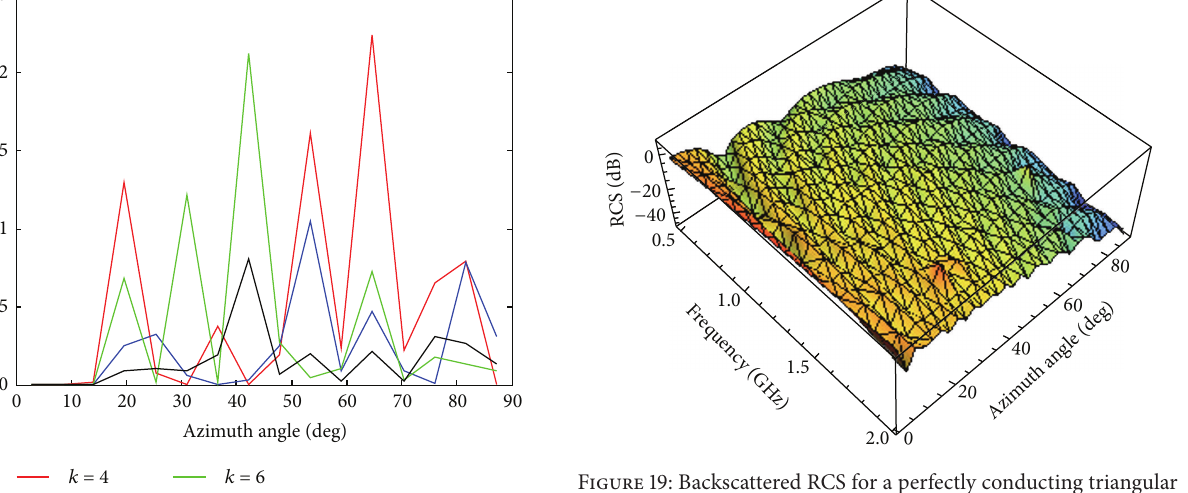
Figure 19: Backscattered RCS for a perfectly conducting triangular flat plate for 𝜃 and frequency of ̂𝑚 = 32.